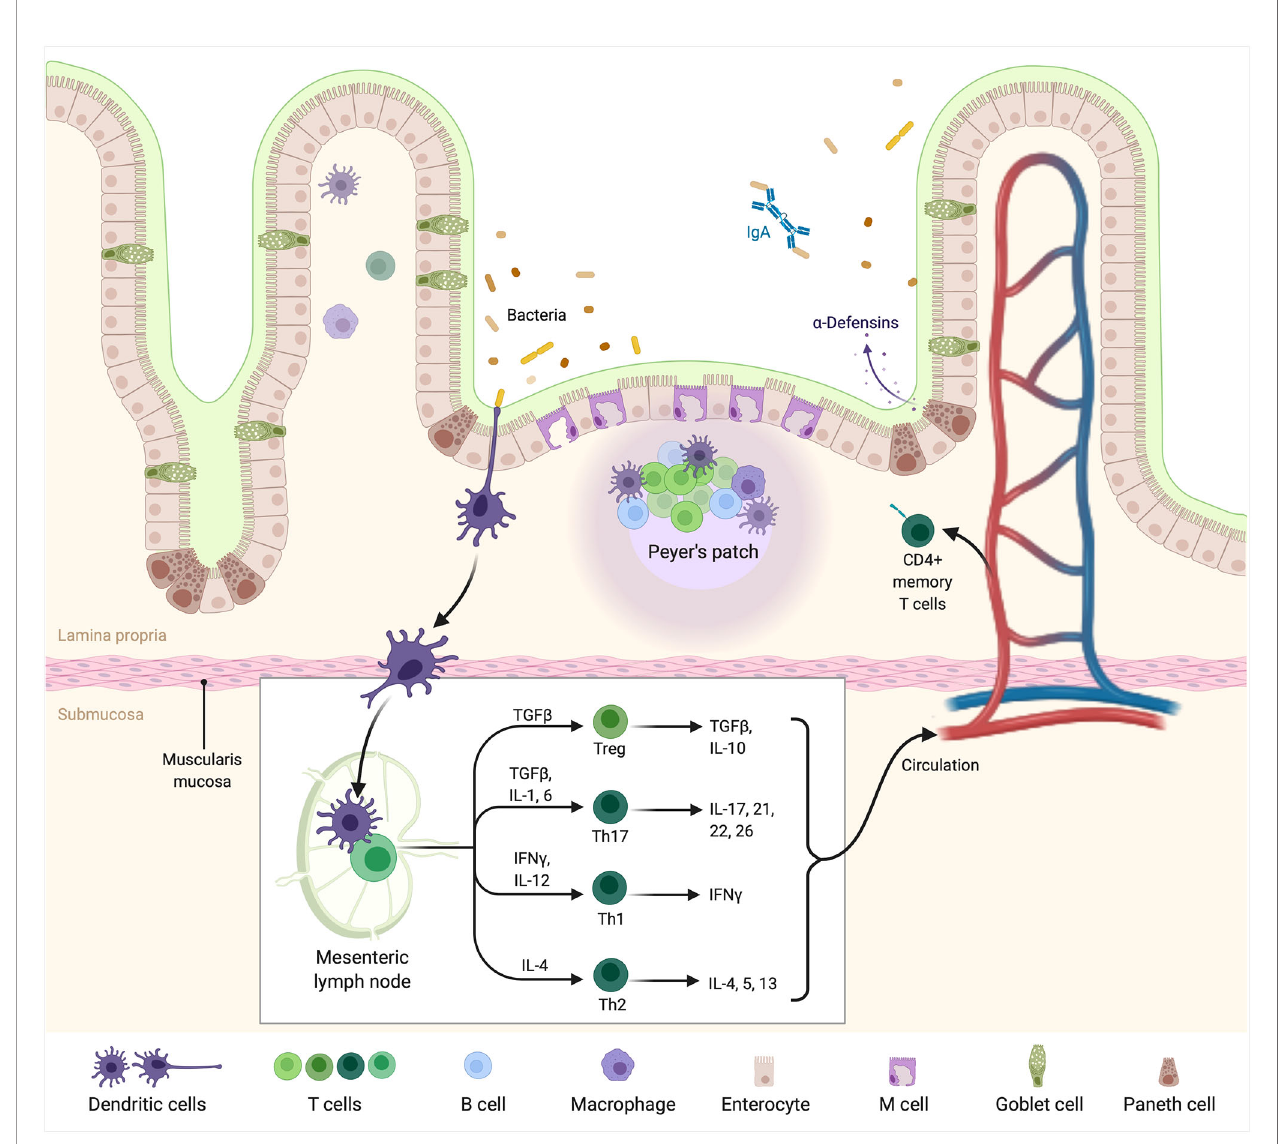
FIGURE 1 | The intestinal immune system. Bacteria currently colonizing the gut are sensed by DCs presenting their antigens in mesenteric lymph nodes or Peyer ’ s patches. In lymph nodes, DCs are accountable for further differentiation of T cells into Treg, Th17, Th1, and Th2 cells producing pro or antiin fl ammatory “ pro fi le ” of cytokines. From the “ myeloma point of view ” particularly important is the balance between Treg/Th17 cells. The latter is accountable for pro-in fl ammatory cytokines such as IL-17 production, which are known to facilitate the development of multiple myeloma. Created with